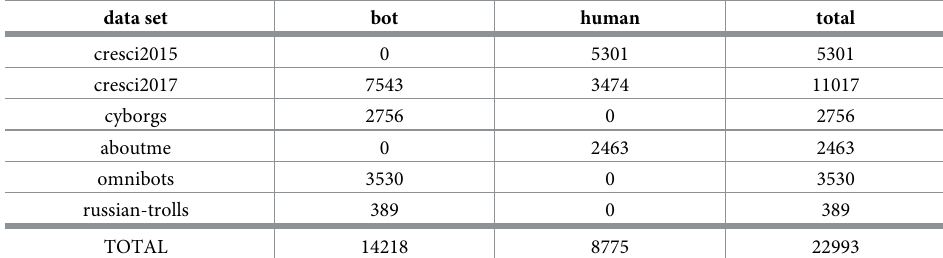
Table 1. Proportions of bot and human users in the training